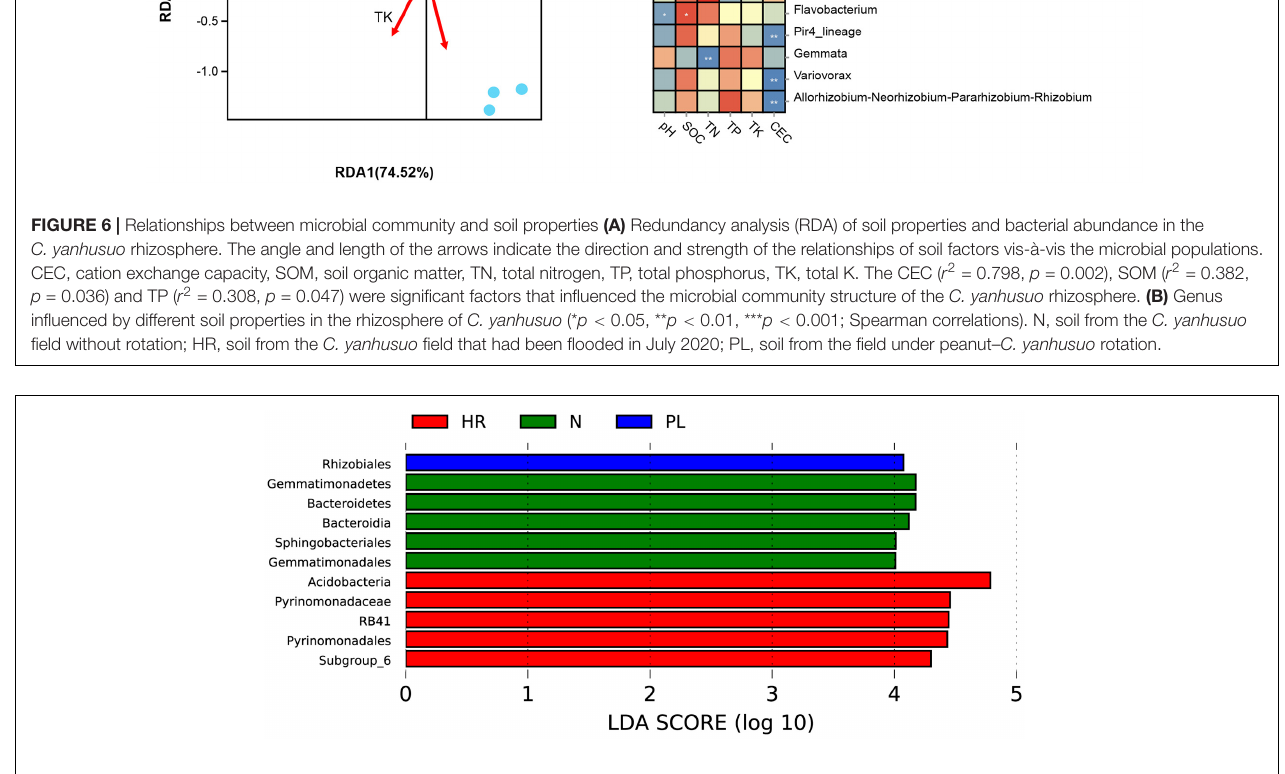
FIGURE 7 | Linear discriminant analysis Effect Size (LEfSe) analysis of microbial abundance in the HR, N, and PL fields. The histogram of linear discriminant analysis (LDA) scores computed for differentially abundant microbes among different samples (these identified at a threshold value of 4.0). N, soil from the C. yanhusuo field without rotation; HR, soil from the C. yanhusuo field that had been flooded in July 2020; PL, soil from field under peanut– C. yanhusuo